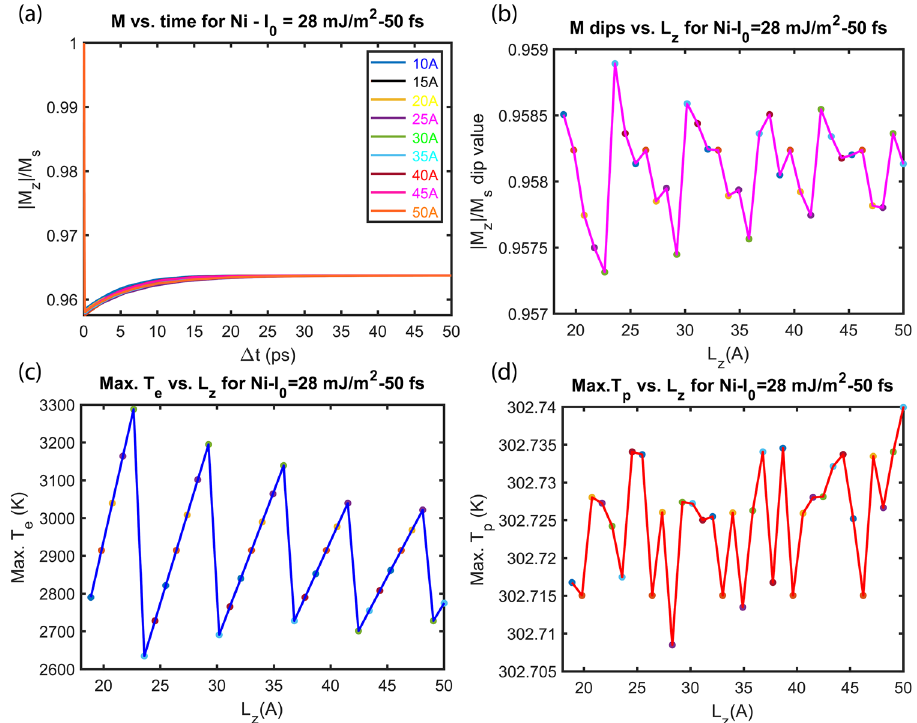
Figure 4. Effect of Ni film thickness L z on ( a ) magnetization dynamics, ( b ) demagnetization dip, ( c ) maximum of electron temperature T e , and ( d ) maximum of phonon temperature T p for L z = 10 Å, 15 Å, 20 Å, 25 Å, 30 Å, 35 Å, 40 Å, 45 Å, and 50 Å. The Ni thin film is illuminated with I 0 = 28 mJ m −2 Gaussian single laser pulse. The rest of the parameters are given in Table 1. The zoomed-in version of panel ( a ) is included in Supplementary Information (Fig.